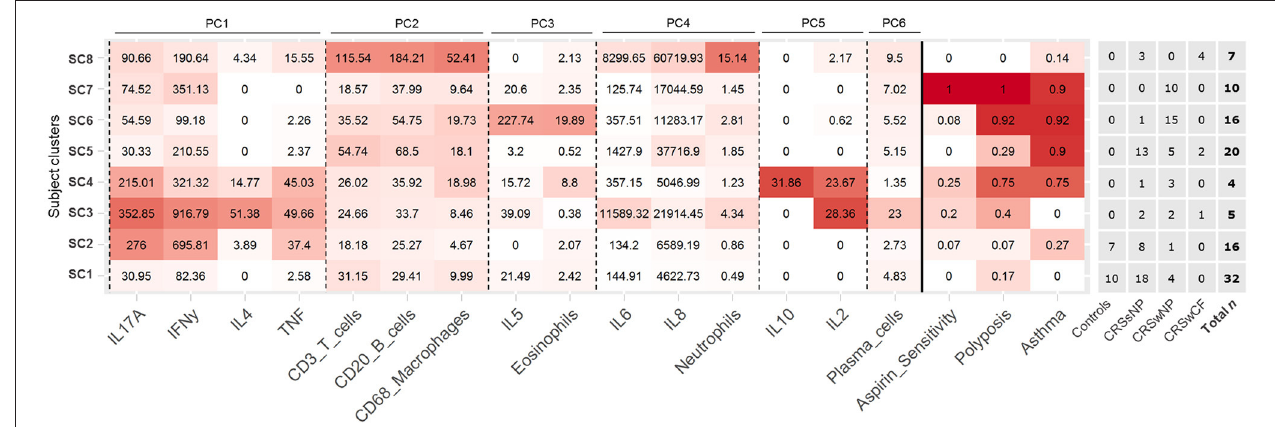
FIGURE 2 | Heat map depicting patterns of inflammatory variables and comorbidities across the eight identified subject clusters [SC1 ( n = 32), SC2 ( n = 16), SC3 ( n = 5), SC4 ( n = 4), SC5 ( n = 20), SC6 ( n = 16), SC7 ( n = 10), SC8 ( n = 7)]. All variables in the heat map were included in the subject clustering analysis. Partitioning of subjects across clinical phenotypes (based on polyposis and cystic fibrosis), and total n for each cluster are given to the right. Variables for each cluster are color coded based on the mean value of the cluster for each variable, with intensity based on a scale of zero to maximum recorded value for each variable. Variables are arranged by principal components analysis results (PC1-6). Subject clusters are ordered based on general